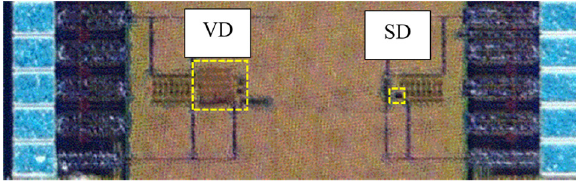
Figure 17. Die photo of SD and VD.